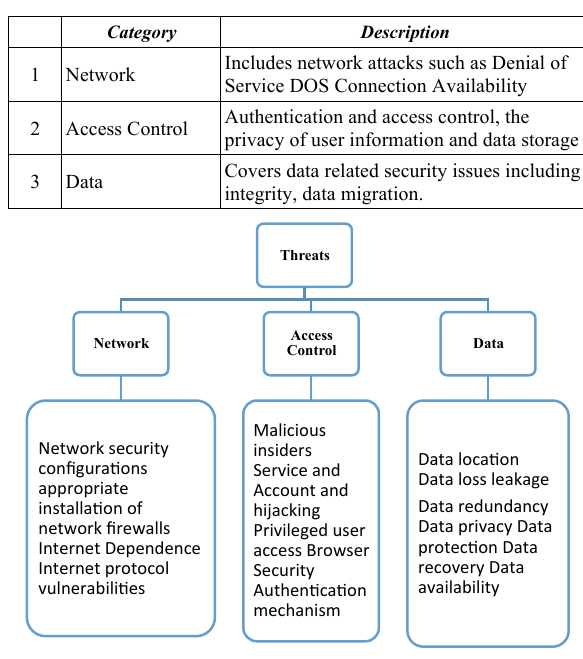
TABLE I. D IFFERENT TYPES OF CLOUD SECURITY CATEGORY